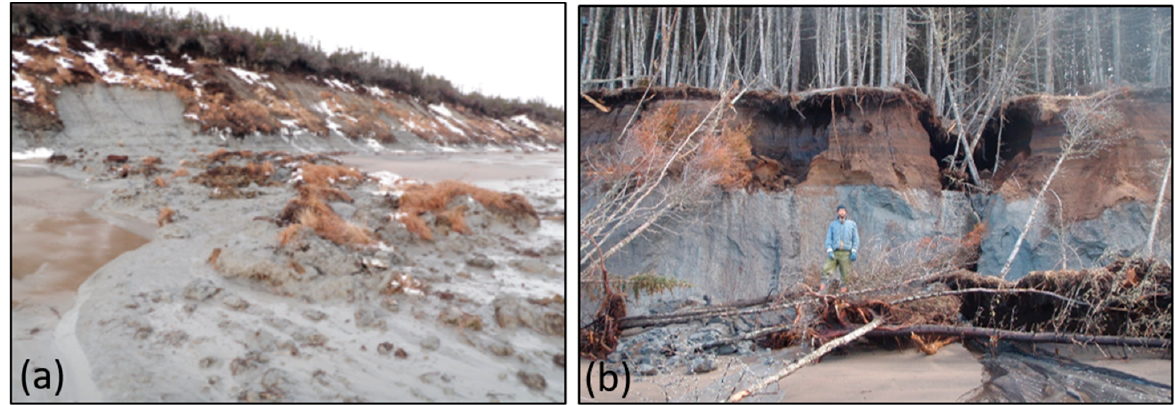
Figure 18. ( a ) Mudflow in April; ( b ) suffosion holes on the sandy unit, 26 April